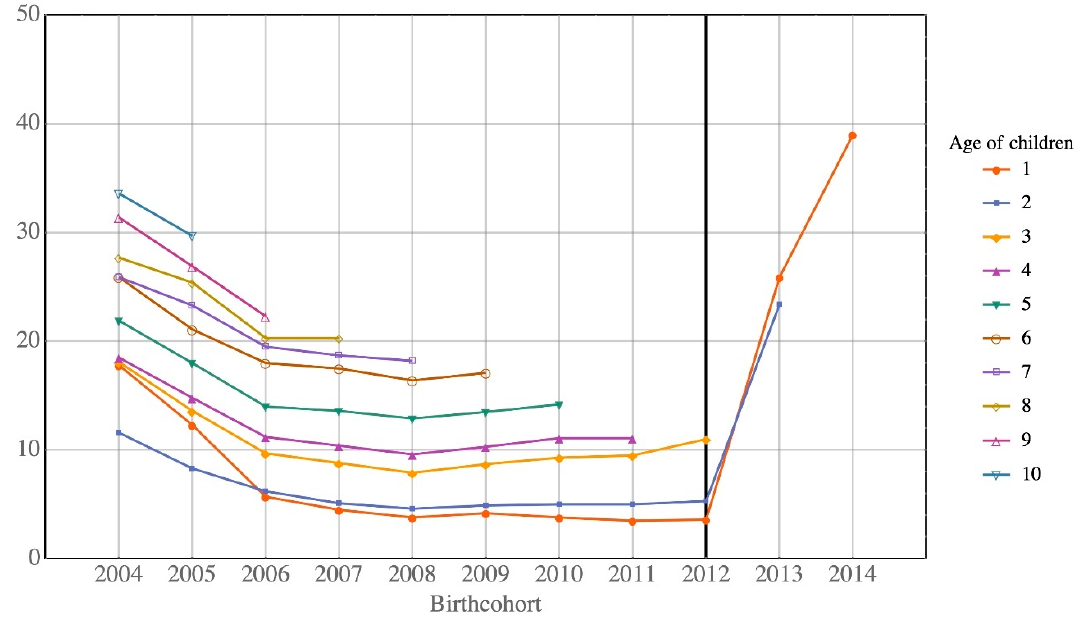
Figure 3. Return rates of Type B children of all ages by birth cohort.